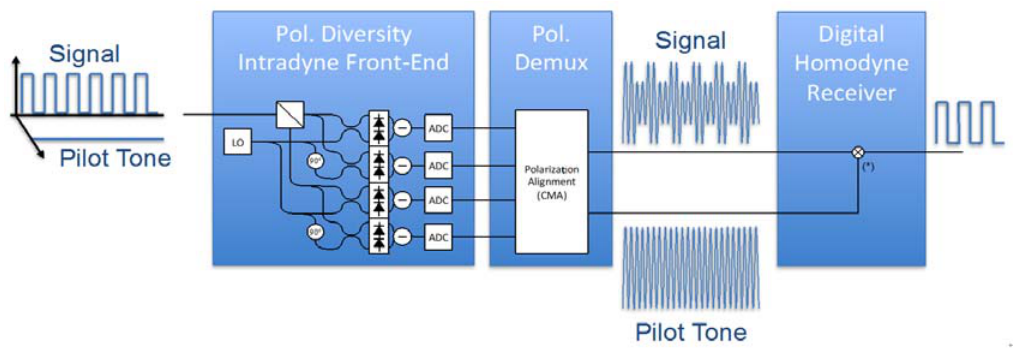
Figure 6. Layout for digital self-homodyne